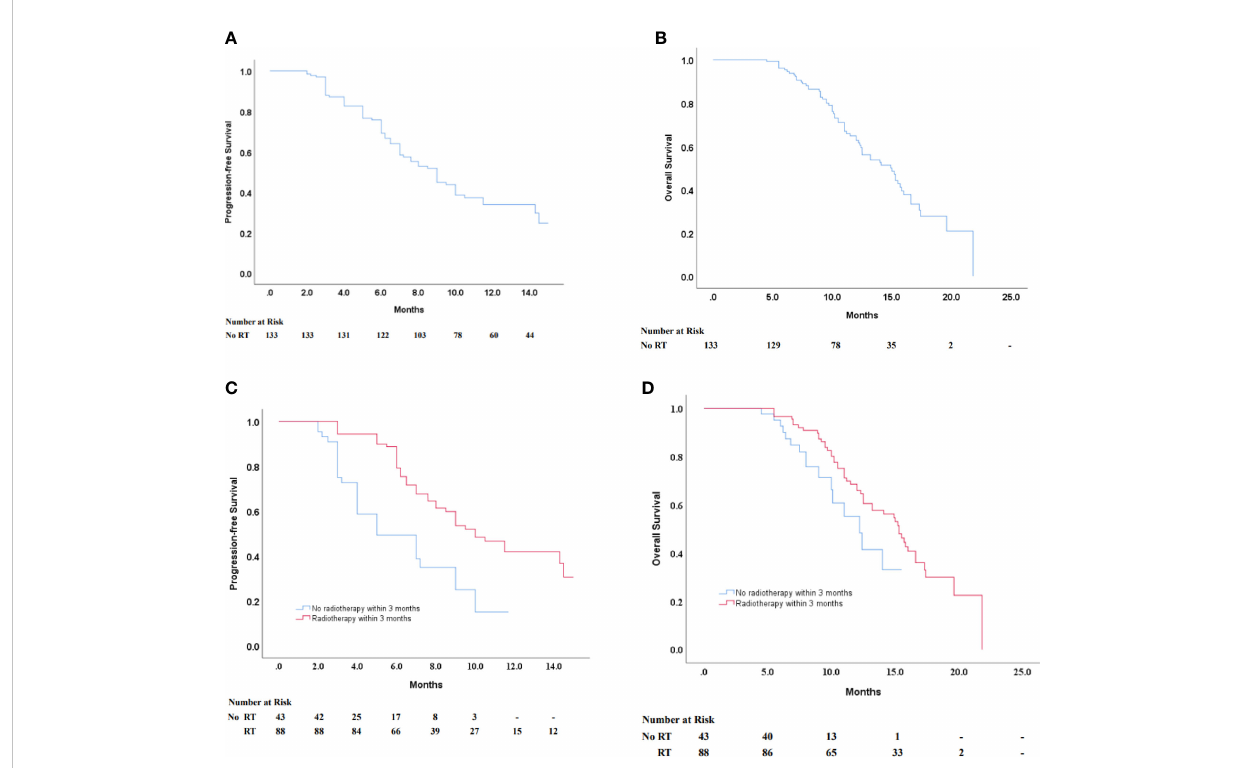
FIGURE 2 (A, B) Kaplan – Maier survival curves of PFS and OS of ESCC patients in all patients. Progression-free survival according to their history of radiotherapy within 3 months before immunotherapy (C) in all patients regardless of PD-L1 expression status (D) in a negative PD-L1 expression status. PFS, progression-free survival; OS, overall survival; ESCC, esophageal squamous cell